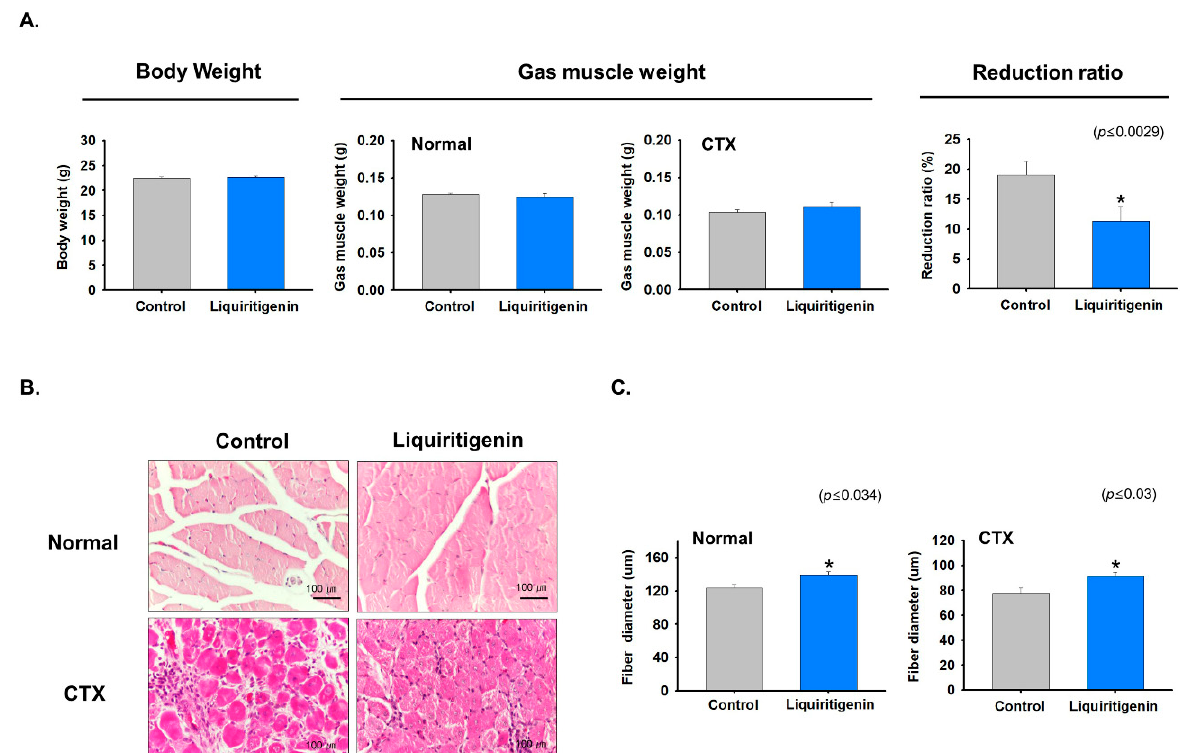
Figure 6. Muscle regenerative effect of liquiritigenin. Mice were orally administered liquiritigenin once a day for nine days from one day before CTX injection. Seven days after CTX injection, muscle tissues were collected from CTX injected and/or liquiritigenin treated mice and treatment naïve controls. ( A ) Body weights (g), gastrocnemius muscle weights (g), and reductions in muscle mass (%). ( B ) H&E stained muscle fibers of CTX injected and/or liquiritigenin treated and treatment naïve controls. ( C ) Muscle fiber diameters of CTX injected and/or liquiritigenin treated and treatment naïve controls determined using Image J. Means ± SD ( n = 10). * p ≤ 0.05. Intact /Control (no CTX injection + no treatment), Intact /Liquiritigenin (no CTX injection + Liquiritigenin treatment), CTX/Control (CTX injection + no treatment), CTX/Liquiritigenin (CTX injection + Liquiritigenin treatment).